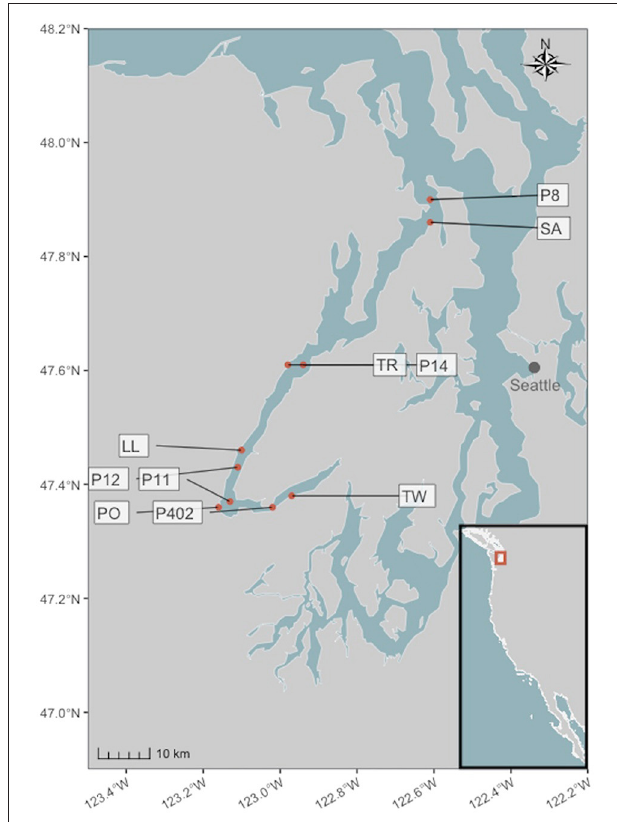
FIGURE 1 | Intertidal and nearshore sampling locations in Hood Canal, Washington, USA. Site abbreviations are described in the text, and coordinates are given in Supplementary Table 1 . Inset map shows the Pacific coast of the continental United